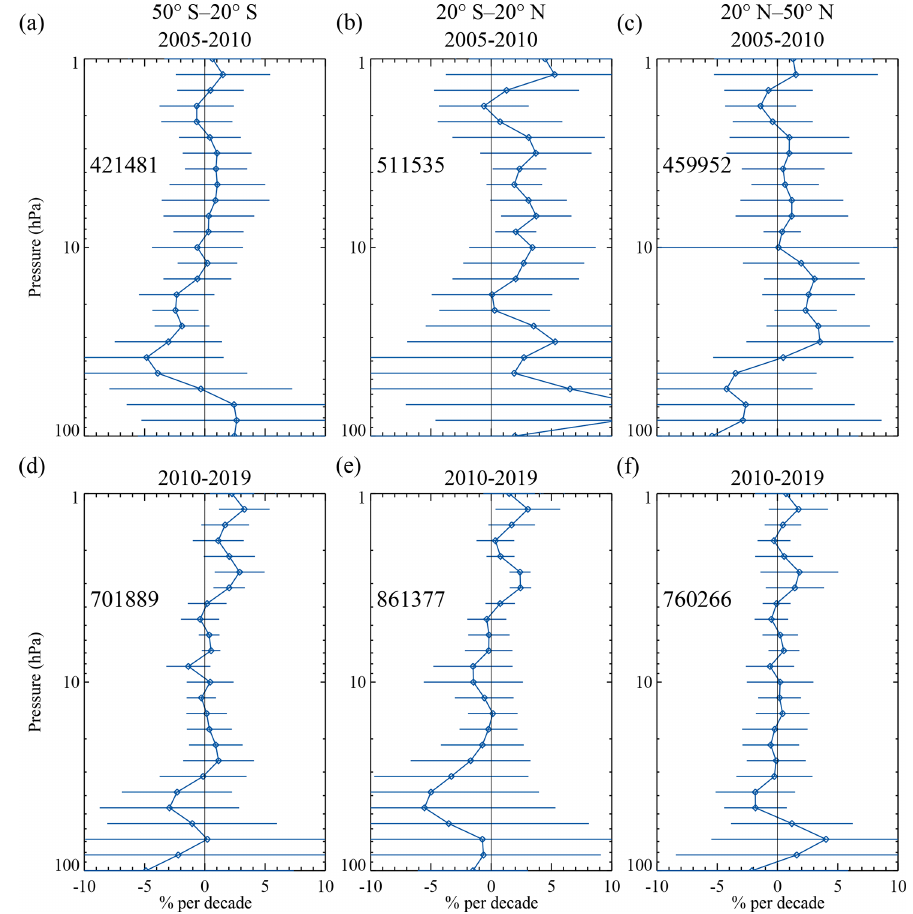
Figure 3. Figure 3 is the same as Fig. 2 but compares MLS v4 water vapor to SABER version